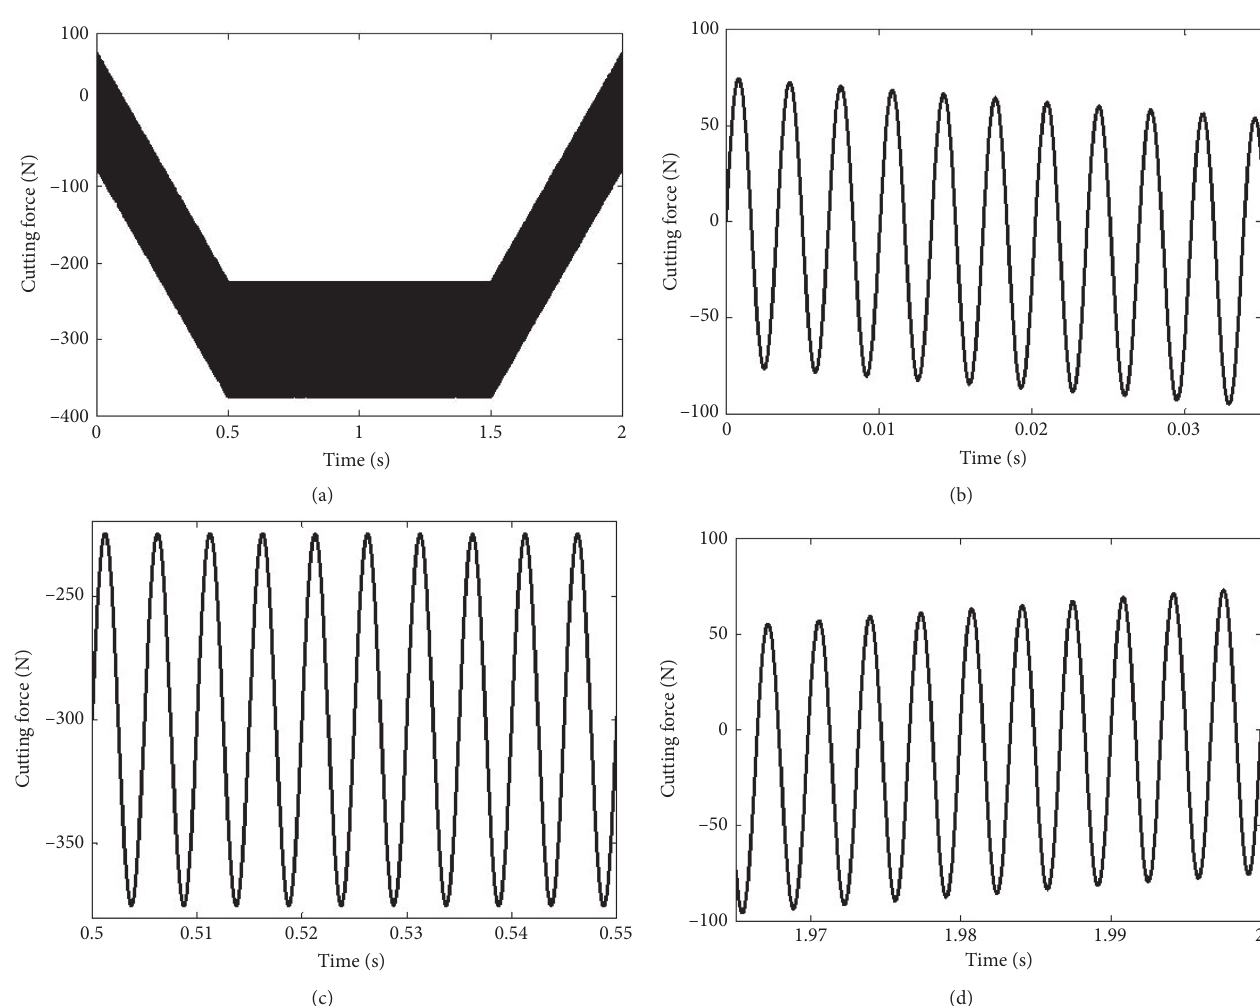
Figure 4: (a) Cutting force. (b) 0 to 0.035s of the force. (c) 0.5s to 0.55 s of the force. (d) 1.965s to 2s of the